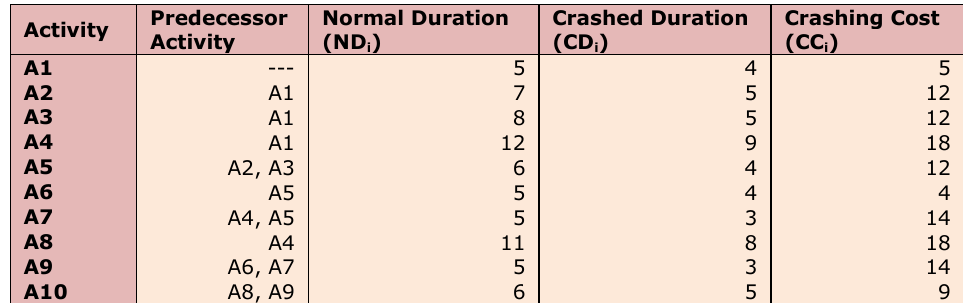
Table 1. Input Data for Activity Crashing of Project